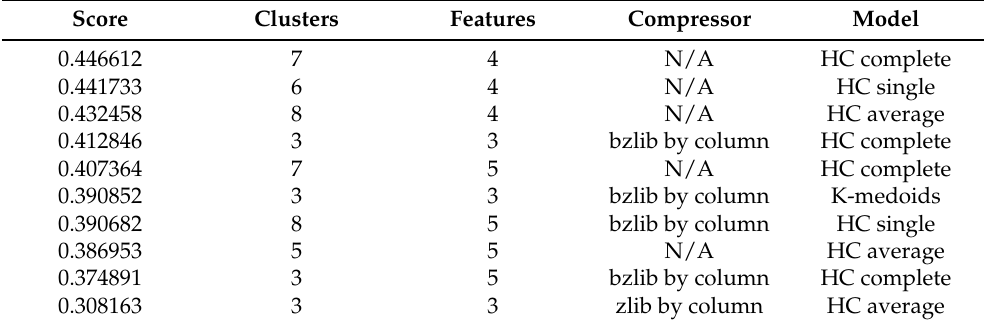
Table 9. Adjusted random scores of the best five clustering by compression and the best five standard compression models for the Golimumab dataset. N/A means that no compressor was